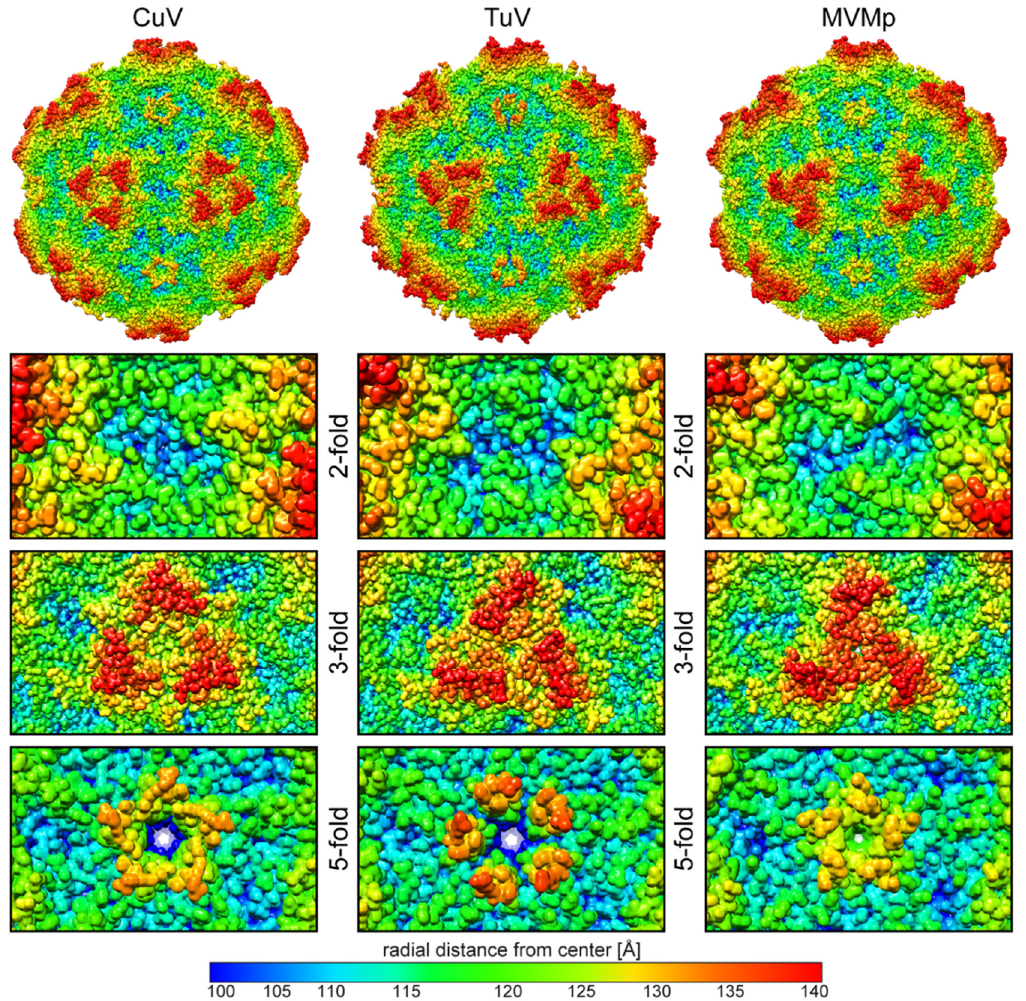
Figure 2. The CuV, TuV, and MVMp capsid surface. Surface representation of the atomic models built into the density maps of CuV, TuV, and MVMp [41] (PDB-ID: 1Z14) and radially colored (blue to red) according to distance from the capsid center, as indicated by the scale bar below. The entire capsid and close-up views of the icosahedral 2-, 3-, and 5-fold symmetry axes are shown. This figure was generated using UCSF-Chimera [27].